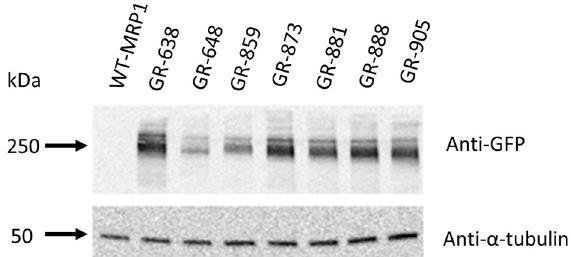
Figure 2. Two-color MRP1 immunoblots. Immunoblots of whole-cell lysates (10 µg) containing wild-type (WT-MRP1) and seven two-color MRP1 constructs. Detection was carried out using rabbit polyclonal anti-GFP antibody (1:5000 dilution, overnight at 4 °C) and mouse monoclonal anti-α-tubulin (1:8000 dilution, overnight at 4 °C).